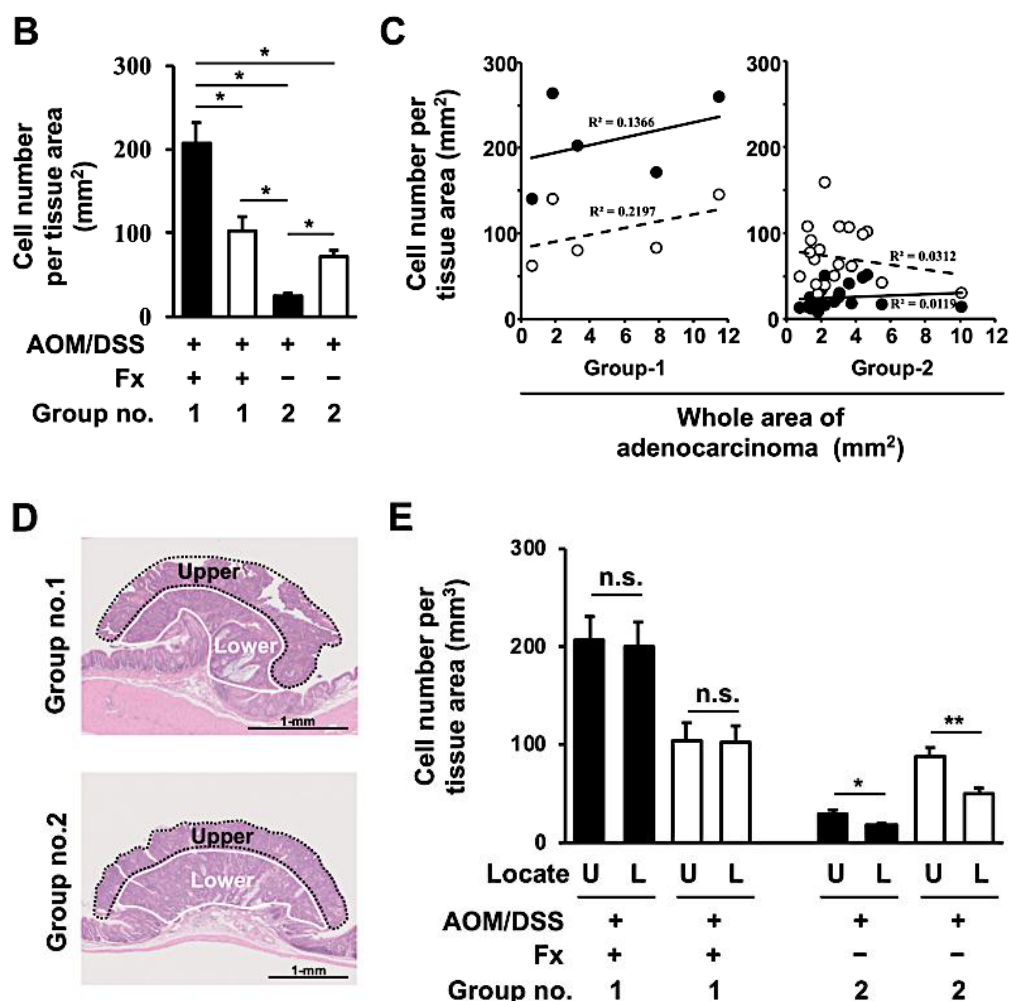
Figure 3. Detection of anoikis-like cells in colon adenocarcinoma of colitis-induced AOM/DSS mice with or without fucoxanthin (Fx) administration. The nuclei (blue fluorescence), cleaved caspase-3 (green fluorescence), and integrin β1 (red fluorescence) were observed by confocal microscopy. ( A ) Arrows show cells with negative/low expression (solid triangular arrows, anoikis-like cells) and high expression (open triangular arrows, non-anoikis-like cells) of integrin β1 plus high expression of cleaved caspase-3. HE, hematoxylin-eosin (HE)-stained sections. Long and short bars are 100 and 5 μm, respectively. ( B ) The number of anoikis-like cells (black box) and non-anoikis-like cells (white box) per tissue area (mm 2 ) was determined by confocal microscopy. ( C ) The correlation plots between the cell number per tissue area and the whole area in adenocarcinoma. X-axis, the whole area of adenocarcinoma (mm 2 ); Y-axis, the number of anoikis-like cells (black circle) and non-anoikis-like cells (white circle) per tissue area (mm 2 ). ( D ) The rough compartment of upper and lower sites in adenocarcinoma. ( E ) The number of anoikis-like cells (black box) and non-anoikis-like cells (white box) per tissue area (mm 2 ) in the upper or lower area in adenocarcinoma. Mean ± SE (group 1, n = 5; group 2, n = 20). Significant di ff erence was performed by one-way ANOVA with a Tukey-Kramer post hoc test or Wilcoxon rank sum test. * p < 0.05 and ** p < 0.01.